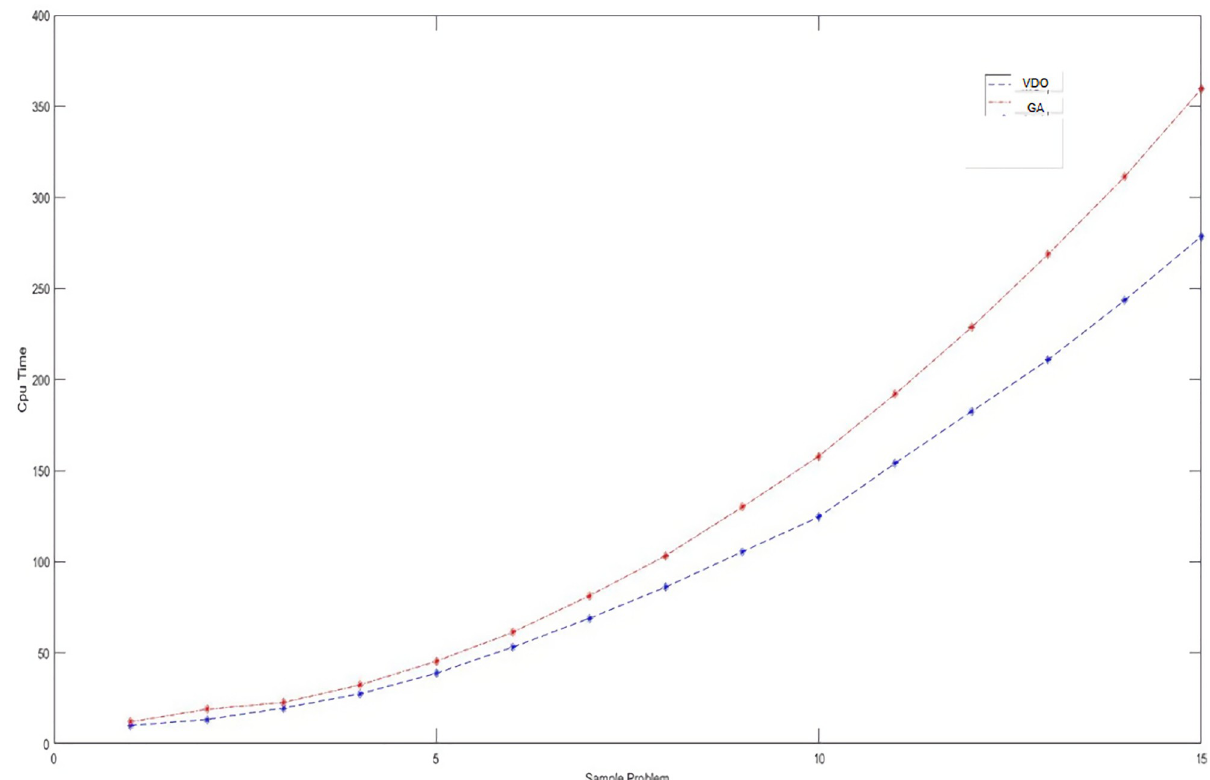
Fig 12. The trend of computational time for the large-sized test problems.